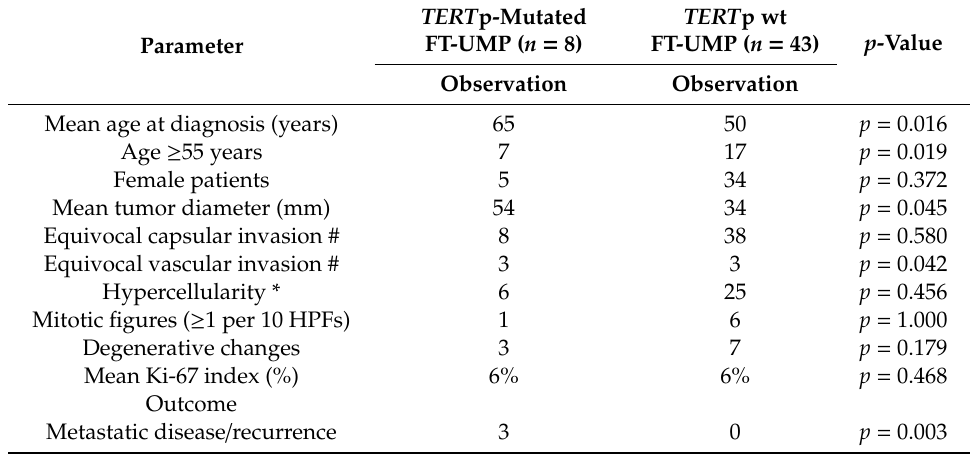
Figure 2. Kaplan–Meier plots illustrating disease-free survival in FT-UMPs and minimally invasive follicular thyroid carcinomas (miFTCs) stratified by TERT promoter ( TERT p) genotype. ( A ) Time to detection of distant metastasis in TERT -promoter-mutated FT-UMP cases compared to wild-type FT-UMP cases. ( B ) Time to metastasis / recurrence in TERT -promoter-mutated FT-UMP cases compared to mutated and wild-type (wt) miFTC cases. The p -values were calculated using a log rank test. Significant p -values are in bold. Table 3. Association with clinicopathological parameters and TERT promoter mutation in